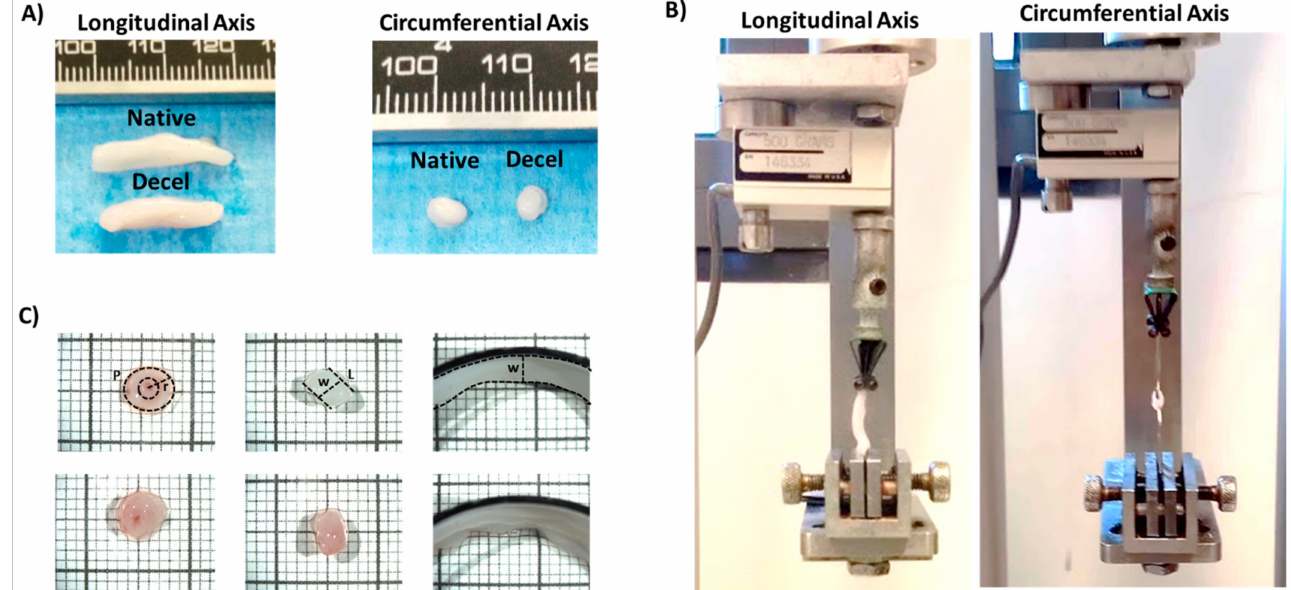
Figure 4. Set up of uniaxial biomechanical analysis of hUAs. Overview of decellularized hUAs in longitudinal and circumferential axis ( A ). Biomechanical testing of hUAs either in circumferential or longitudinal axis ( B ). Determination of hUAs dimensions using the stereoscope ( C ). P: Perimeter, r: radial, W: Width, L: